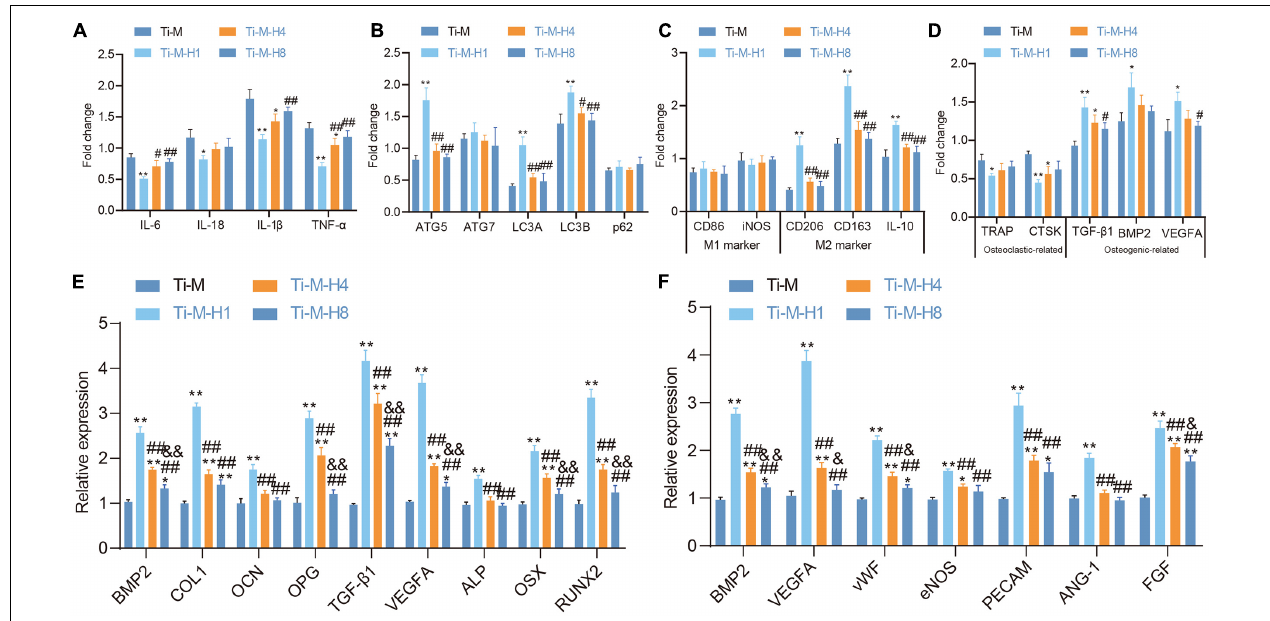
FIGURE 4 | Ti–M–H coating on macrophage immunomodulation, osteogenesis, and angiogenesis. (A) RT-qPCR to detect the effect of coating surface on the expression of macrophage inflammatory factors. (B) RT-qPCR to detect the effect of coating surface on the expression of macrophage autophagy factors. (C) RT-qPCR to detect the effect of coating surface on the expression of M1 and M2 factors. (D) Effect of sample surface on macrophage osteoclast and osteogenic factors. (E) RT-qPCR to detect the expression of osteogenic-related genes in SCMM. (F) RT-qPCR to detect the expression of angiogenic-related genes in SCMM. * P < 0.05 compared with Ti–M. # P < 0.05 compared with Ti–M–H1. & P < 0.05 compared with Ti–M–H4. ** P < 0.01 compared with Ti–M. ## P < 0.01 compared with Ti–M–H1. && P < 0.01 compared with Ti–M–H4. The experiments were repeated three